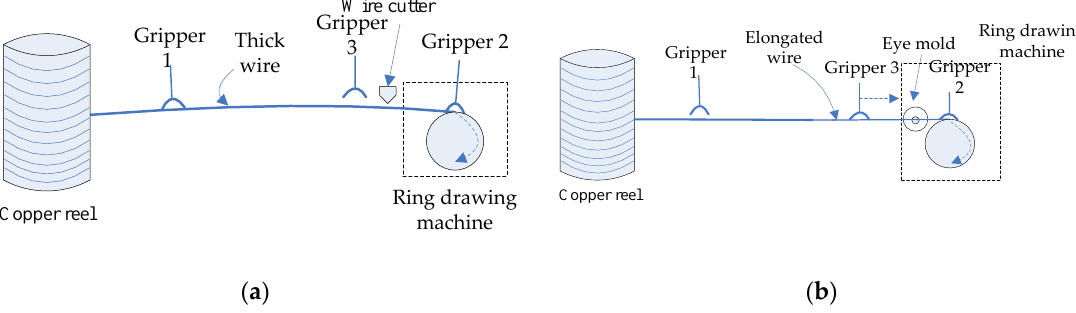
Figure 5. Profile of proposed system operation. ( a ) Profile of elongating wire; ( b ) profile of dies mold threading.